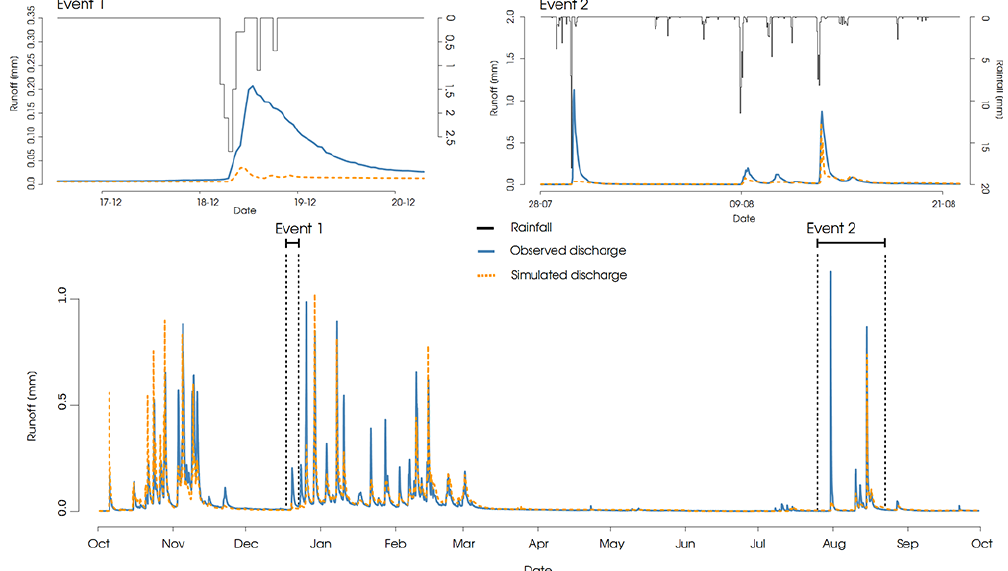
Figure 10. Observed and simulated runoff of the Wollefsbach catchment. Two rainfall–runoff events are highlighted and displayed